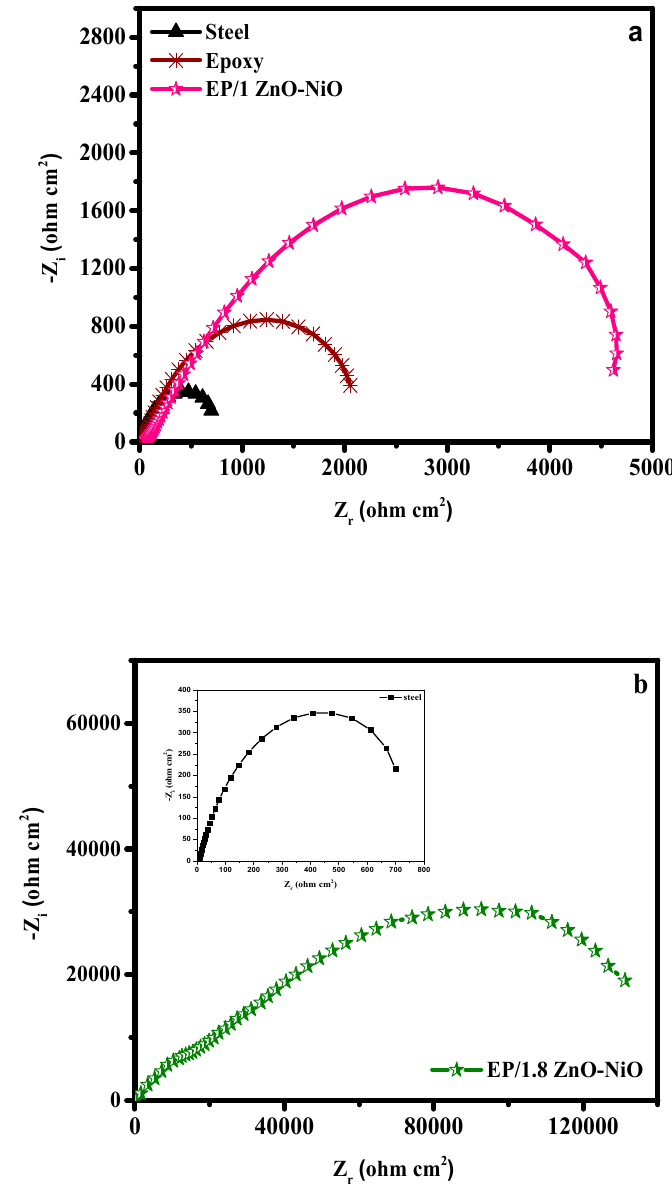
Figure 4. ( a ) Nyquist plots attained for steel, epoxy and EP/1.0 ZnO-NiO nanocomposites and ( b ) EP/1.8 ZnO-NiO nanocomposite coated mild steel submerged in 3.5% NaCl solution (inset: